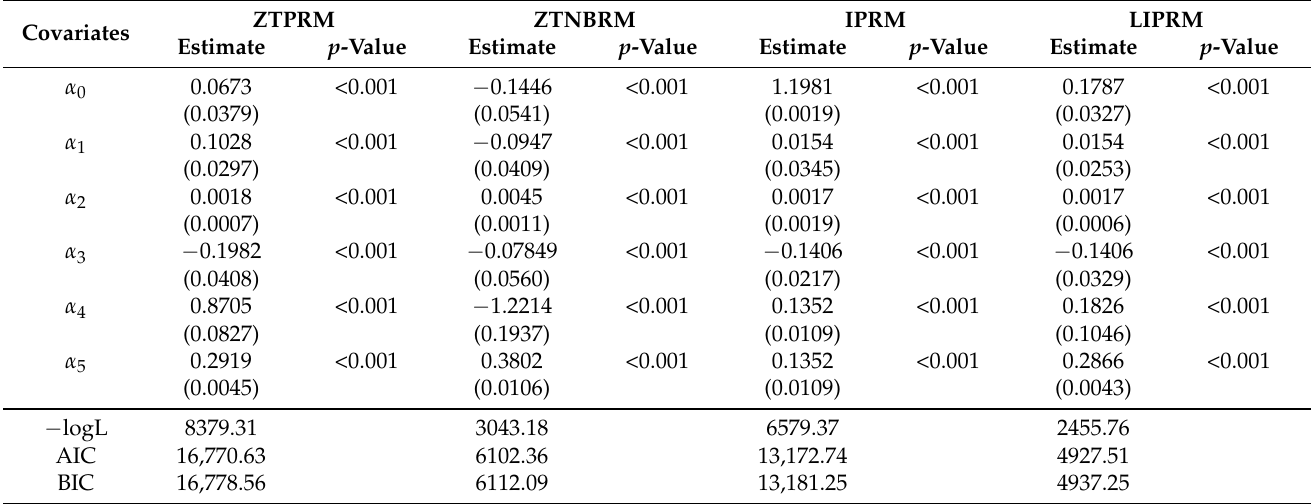
Table 8. The results of the regression models for the NHIS of Nigeria (SEs in